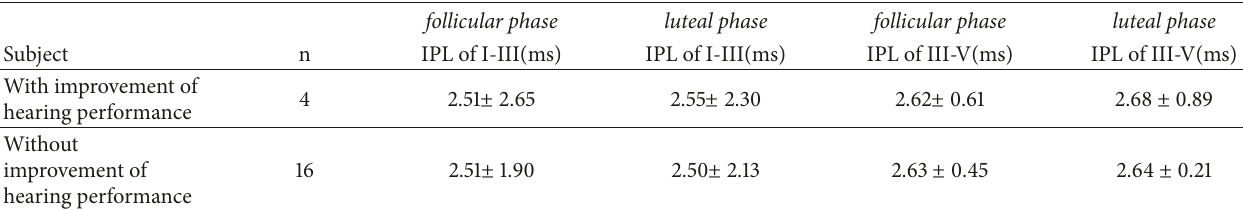
Table 2: Mean and standard deviation of auditory brainstem response (ABR) interpeak latencies (IPLs) of twenty healthy female in follicular- luteal